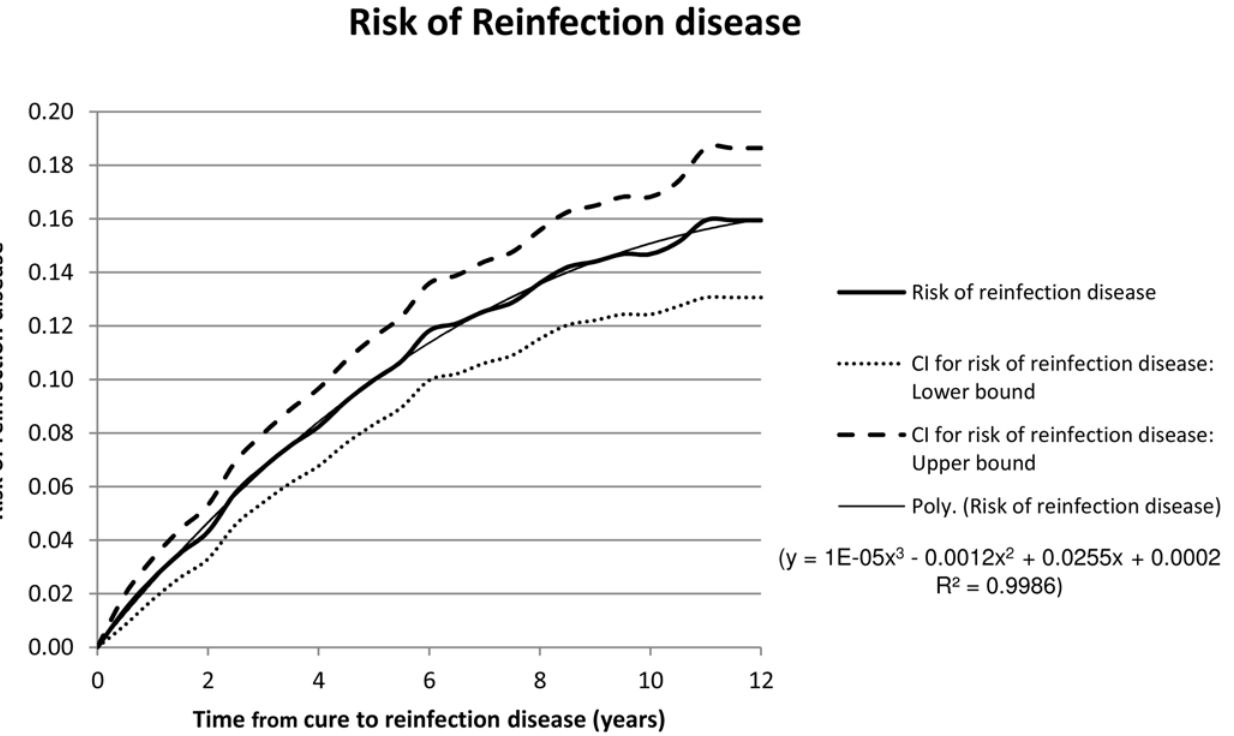
Fig 3. The mean risk of reinfection disease manifesting a given number of years after cure of a prior cured disease episode is shown together with confidence intervals. Trend lines are fitted and these are used to estimate the gradients of the risk graphs. The trendline for the mean risk of reinfection disease only is shown and its parameters are